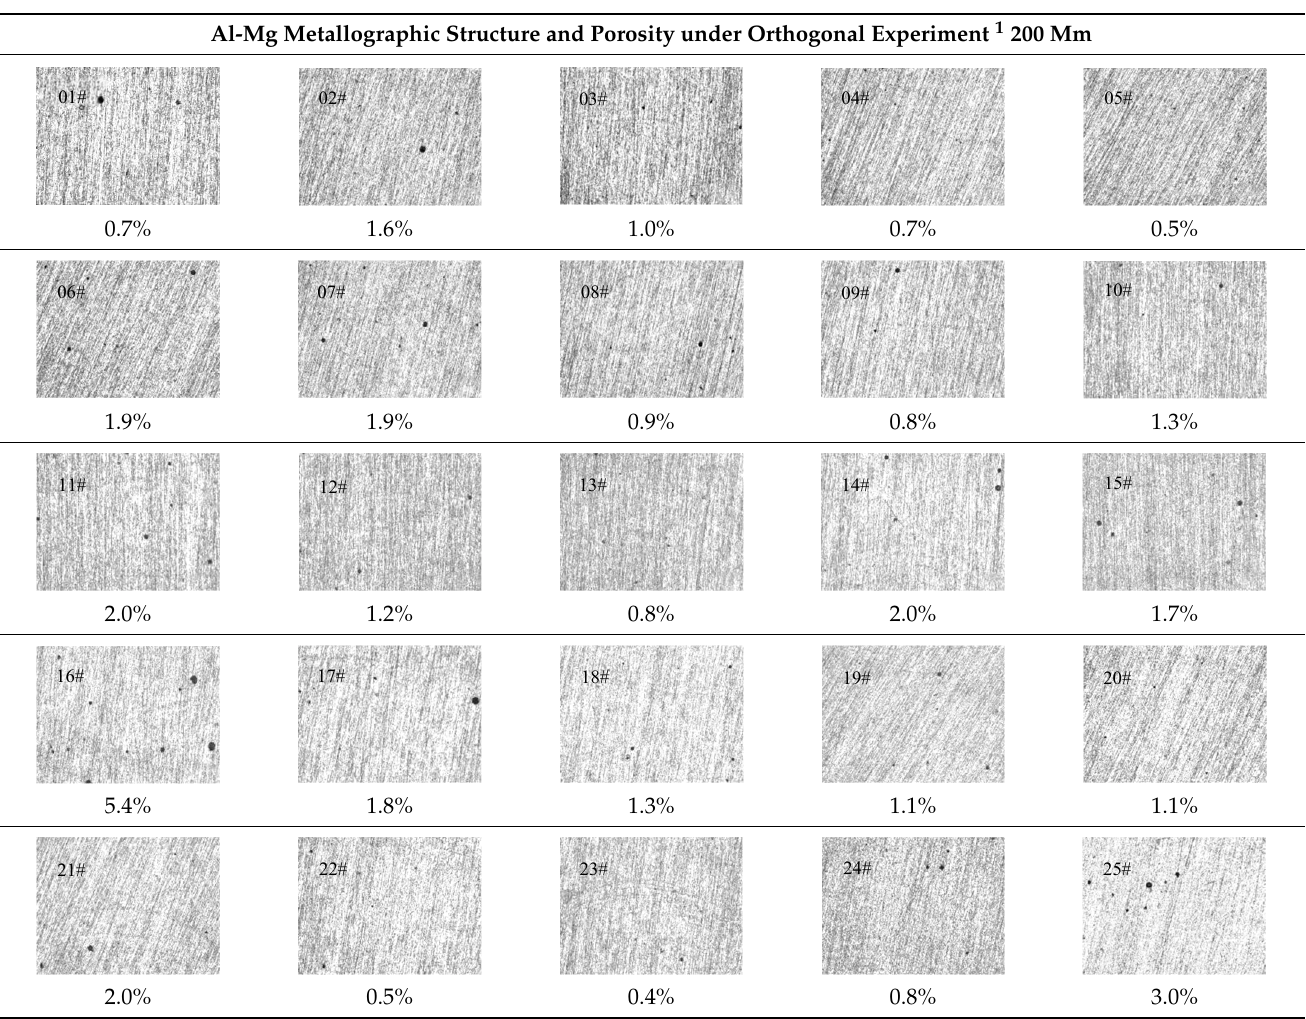
Table 4. Al-Mg metallographic structure under orthogonal process parameters.